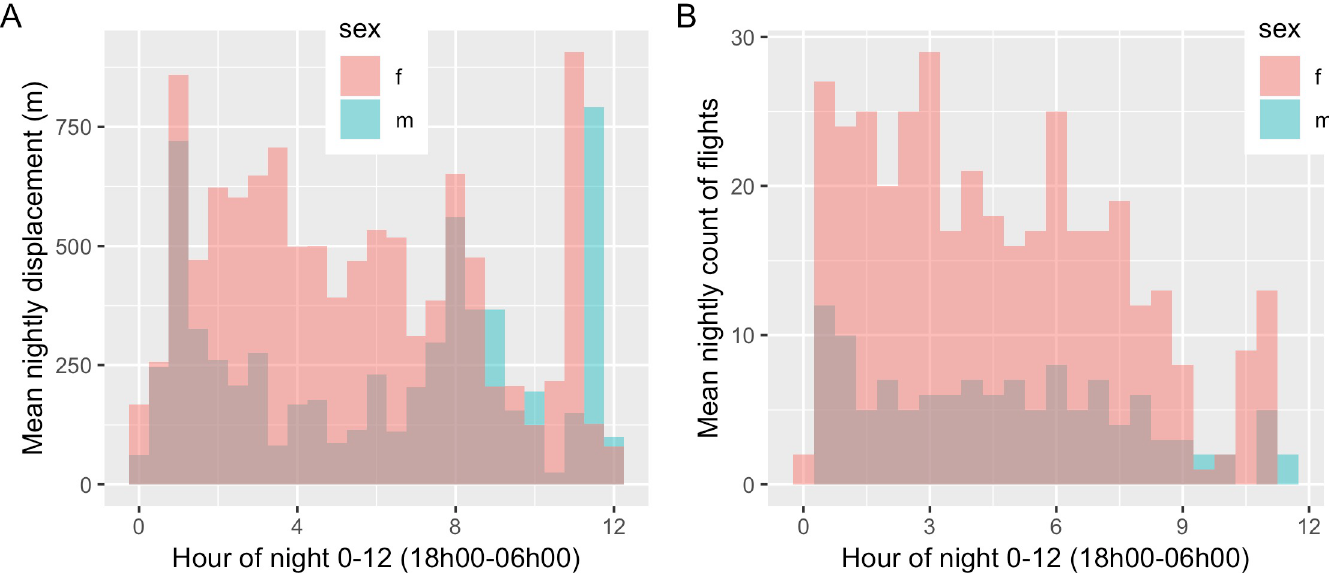
Fig 4. Nightly bat flight activity. (A) Barplot of GPS-based distance flown every 30 min beginning at 18h00 (time zero in plot) and 06h00 (time 12 in plot) and (B) of flight behavior observations as determined by accelerometry over the same period.